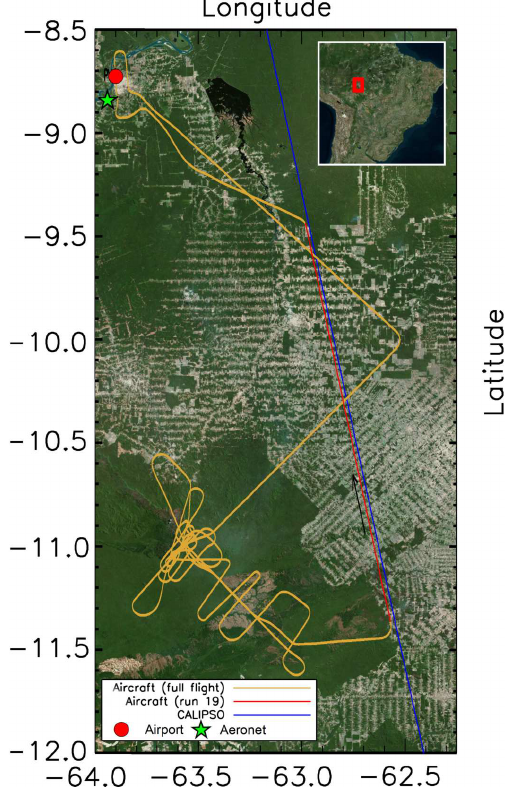
Figure 1. Yellow line: full flight track of the BAe-146 aircraft on 20 September 2012 (flight B737). Red line: aircraft track for the flight section between 17:49:20 and 18:12:46UTC (Run 19). Blue line: CALIPSO footprint on the same date, between 18:00:37 and 18:01:41UTC. Porto Velho is marked near the top left corner: red circle, airport; green star, AERONET